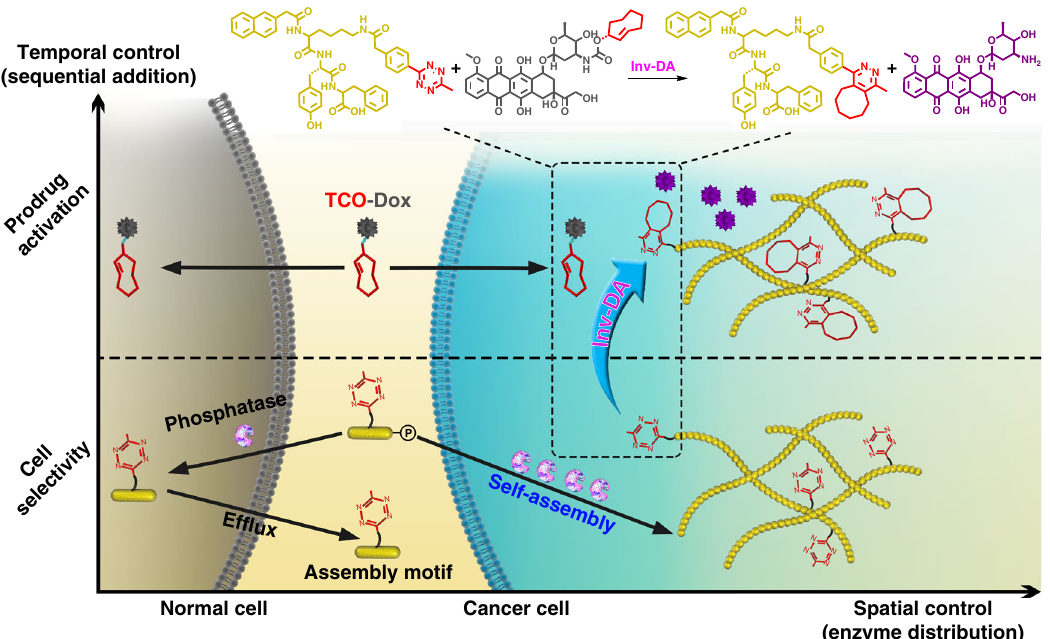
Fig. 1 Synergistic enzymatic and bioorthogonal reaction for prodrug activation in cancer cells. The process of enzyme-instructed supramolecular self- assembly selectively accumulates prodrug activation triggers in cancer cells in response to the over-expressed phosphatase. Thereafter, the prodrugs are speci fi cally activated by the accumulated triggers through a biorthogonal reaction, which lead to cancer cells death. Inv-DA, inverse electron-demand Diels – Alder